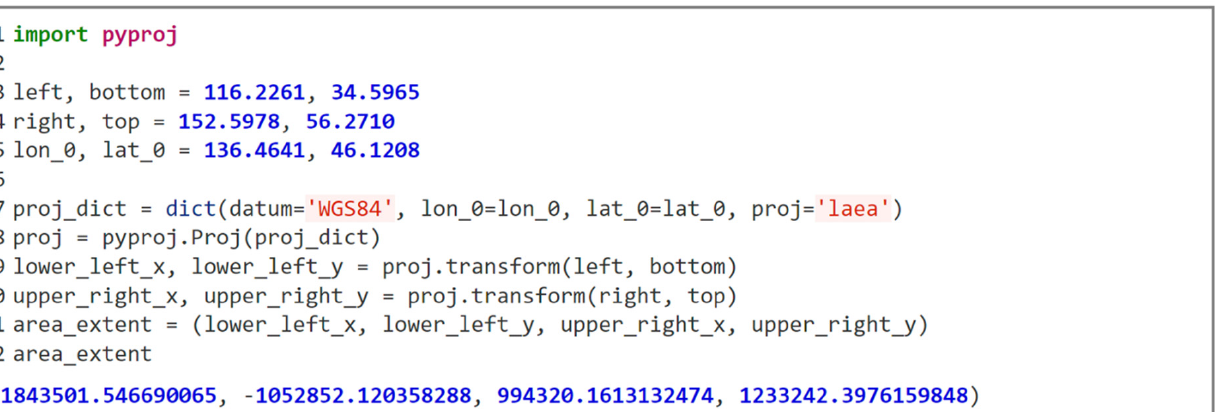
Figure A2. Python code snippet for projection initialization. The Lambert azimuthal equal-area projection (LAEA) is initialized with the center located at the swath scan line center longitude/latitude median point. The initialized projection was then used to translate the swath bounds in degrees into the target projection distances in meters. WGS84 stands for World Geodetic System (WGS) 1984, consisting of a reference ellipsoid, a standard coordinate system, altitude data, and a geoid.